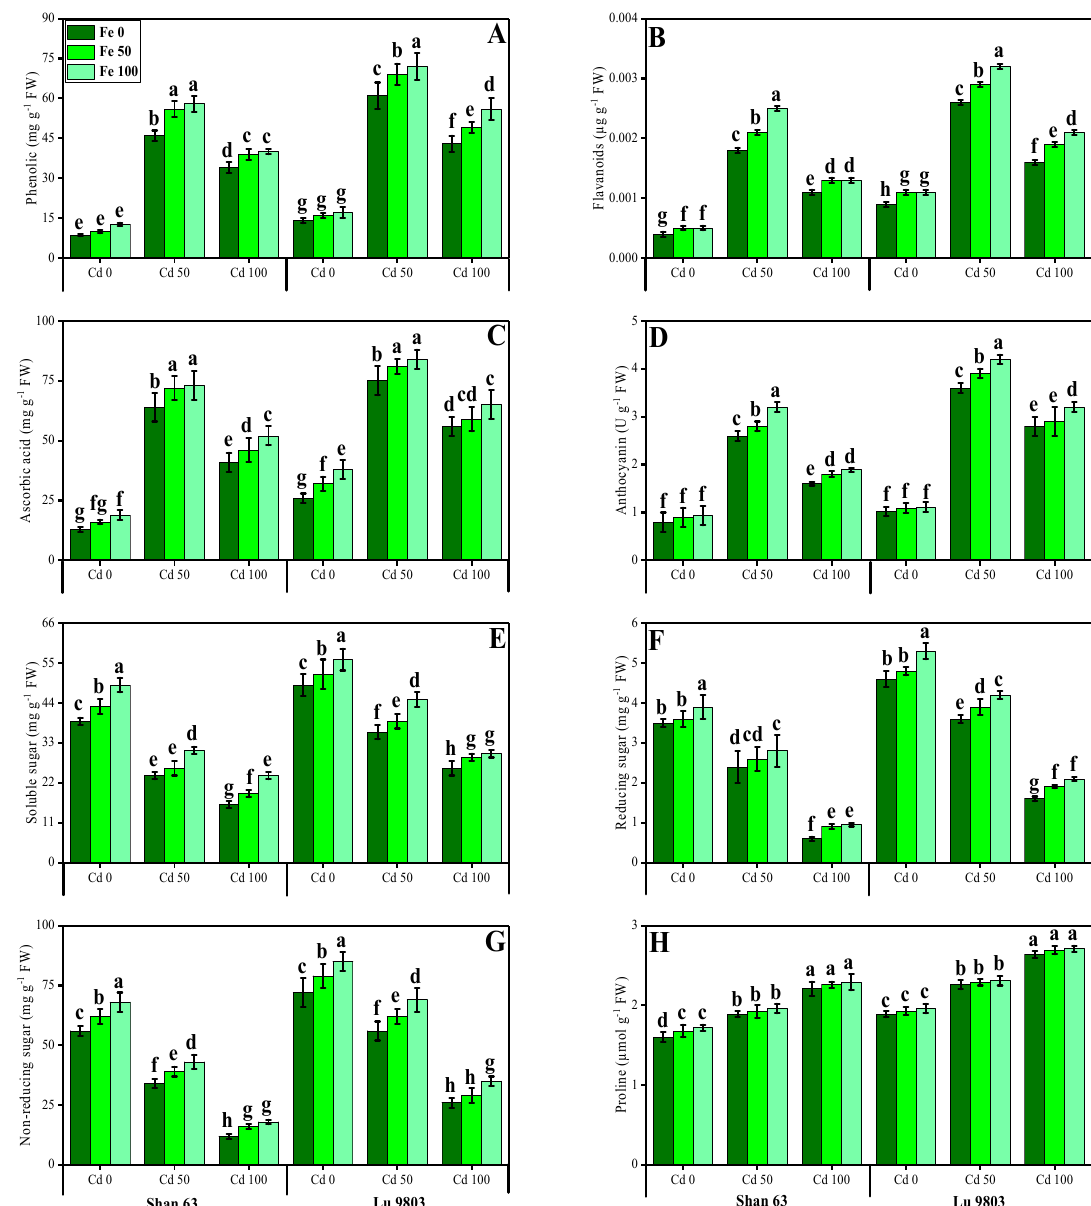
Figure 5. E ff ect of di ff erent concentrations of exogenous application of FeSO 4 (0, 50, and 100 µ M) on non-enzymatic antioxidants and sugars, i.e., phenolic contents ( A ), flavonoid contents ( B ), ascorbic acid contents ( C ), anthocyanin contents ( D ), soluble sugar contents ( E ), reducing sugar contents ( F ), non-reducing sugar contents ( G ) and proline contents ( H ) in the leaves of Oryza sativa (cultivars) grown under di ff erent levels of Cd stress (0, 50, and 100 µ M). Bars sharing di ff erent letter(s) for each parameter are significantly di ff erent from each other according to Duncan’s multiple range test ( p < 0.05). All the data represented are the average of four replications ( n = 4). Error bars represent the standard deviation (SD) of four